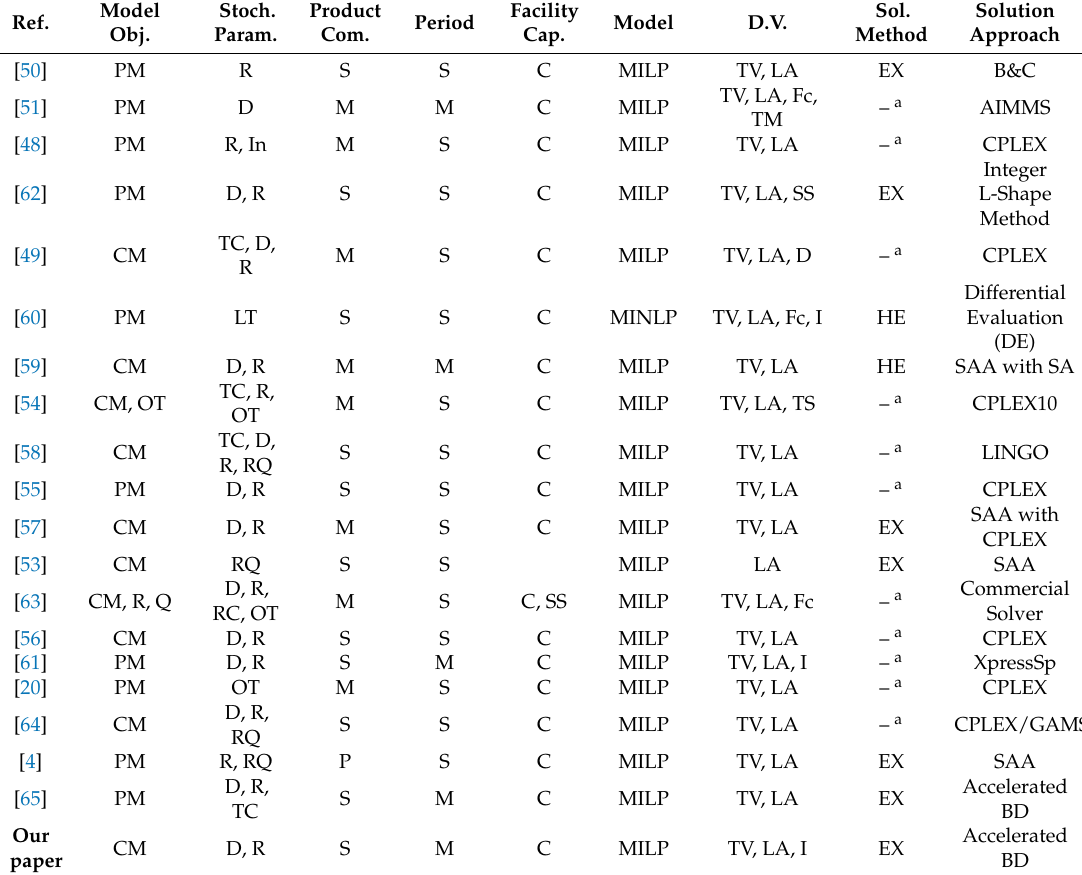
Table 2. Summary of stochastic integrated forward/reverse logistic network design.